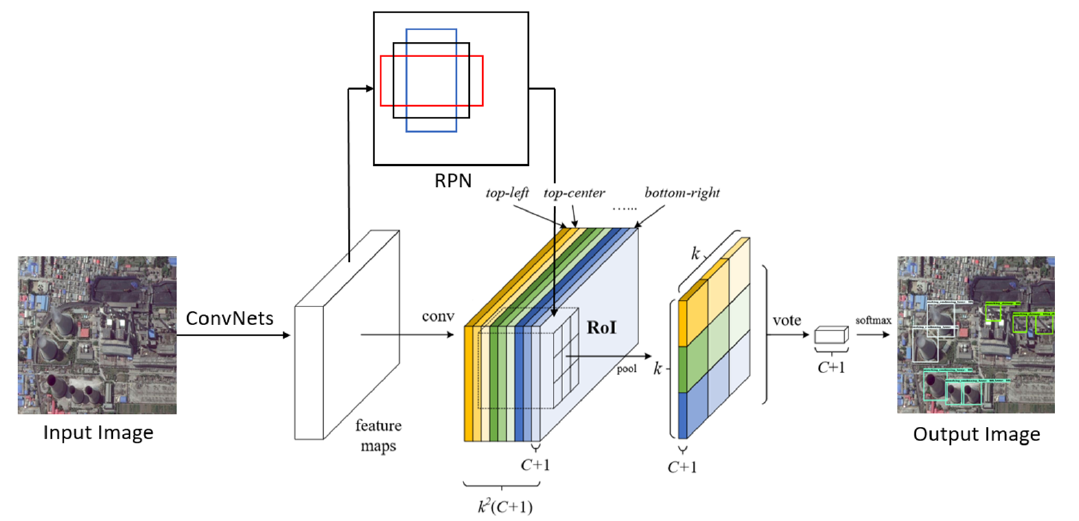
Figure 3. The framework of R-FCN. RPN, region proposal network; RoI, region of interest; ConvNets and conv, convolutional network.